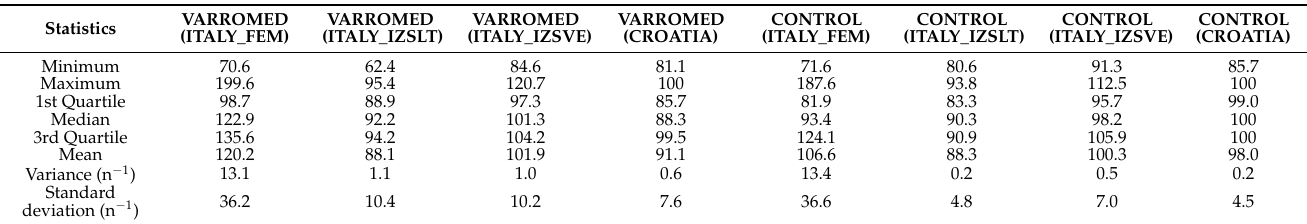
Figure 7. Box plot of acaricide efficacies recorded during the winter trial and relative mite fall during the same period in the control group (%). The horizontal line in boxes shows the median. The box shows the first and third quartile. Whiskers extend to 1.5 × interquartile range (IQR). Additionally, the pluses show mean values. Small variations of coverage of adult honey bees were recorded but no statistically significant differences were observed (Table 6; Figure 8). No queen mortality and no clin- ical signs of other economically important diseases were observed. Table 6. Variation of adult honey bee coverage in all groups recorded during the winter trial compared to the beginning of the treatment (%). Statistics